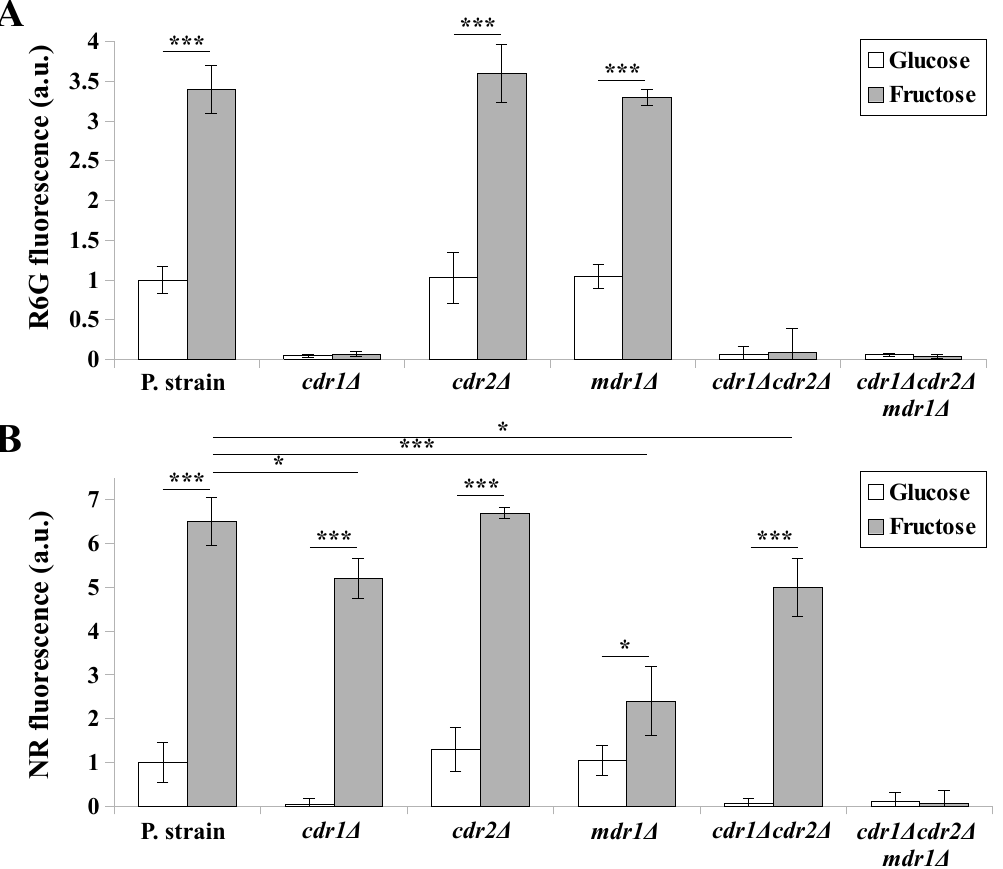
Figure 2. The activity of multiple drug resistance (MDR) transporters measured by ( A) rhodamine 6G (R6G), or ( B) Nile red (NR), efflux in C. albicans CAF2-1 (parental strain), DSY448 ( cdr1 ∆ ), DSY653 ( cdr2 ∆ ), DSY465 ( mdr1 ∆ ), DSY654 ( cdr1 ∆ cdr2 ∆ ), and DSY1050 ( cdr1 ∆ cdr2 ∆ mdr1 ∆ ) strains grown in yeast nitrogen base glucose (YNBG) or yeast nitrogen base fructose (YNBF) media for 8 h at 28 °C. Fluorescence intensities (IFs) of extracellular dyes were normalized (=1 for the YNBG-grown CAF2-1 strain) (means ± SD, n = 3, a.u. – arbitrary units). Statistical analysis was performed between YNBG- and YNBF-grown cells or between different strains (*, p < 0.05, and ***, p < 0.001).